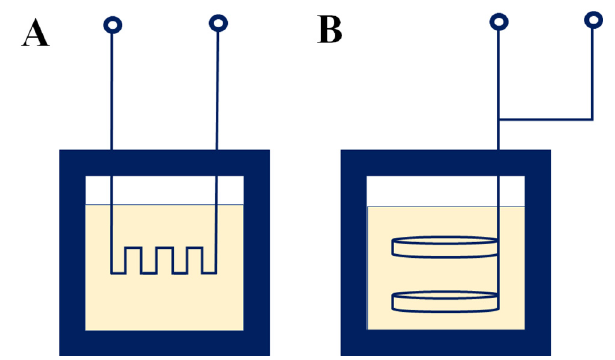
Figure 4. Schematic of the heaters: ( A ) meander heater; ( B ) type Joule